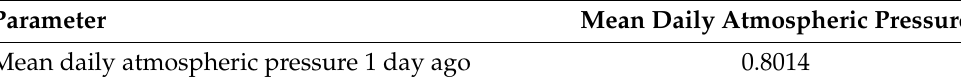
Table 14. The parameters with the strongest correlation to the predicted mean daily atmospheric pressure.